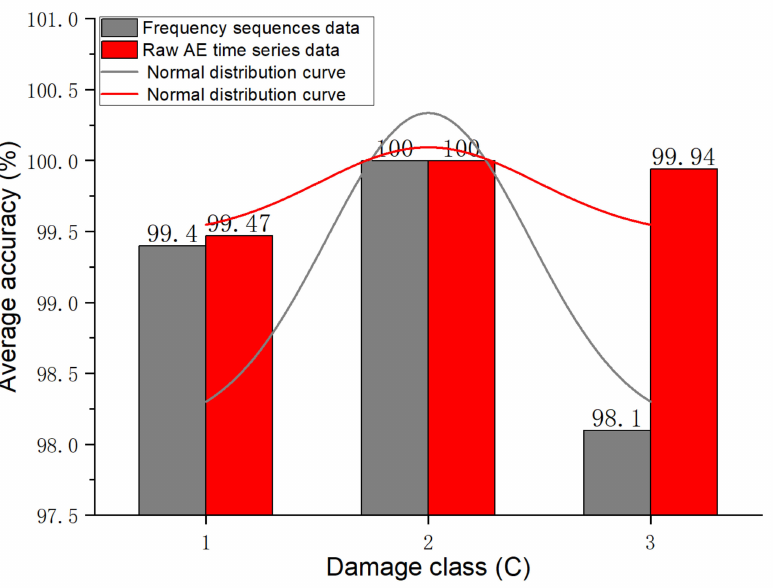
Figure 14. Comparison of the average test accuracy based on the raw AE time series data and frequency-domain sequence data for C1, C2, and